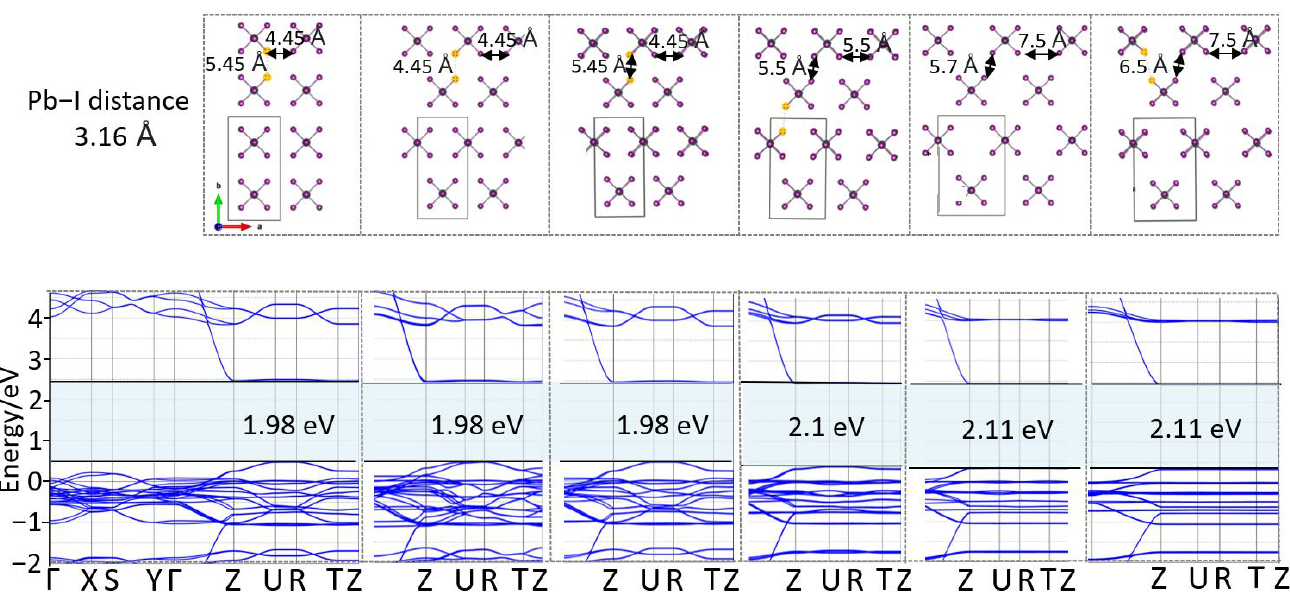
Figure 3. Calculated band structures for hypothetical 1D perovskite-derived structures with different distances between the [PbI 5 ] 3 − chains.